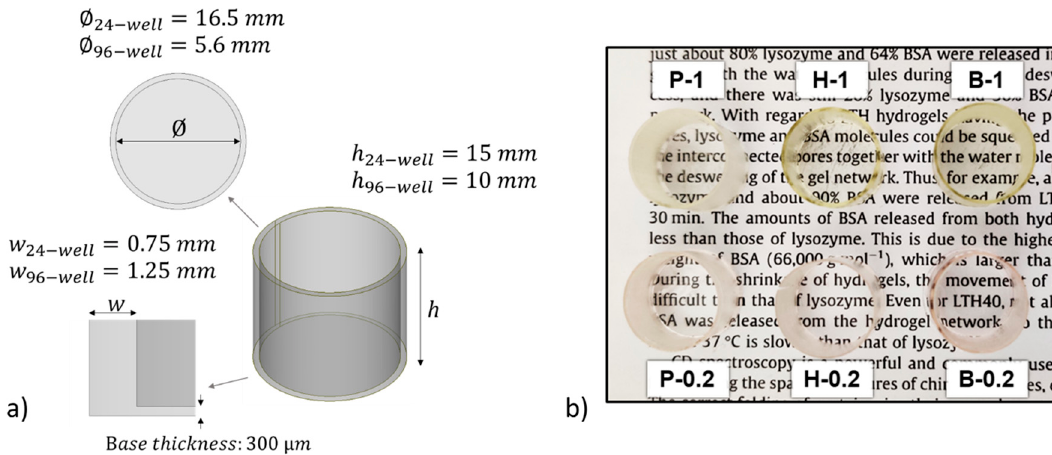
Figure 2. ( a ) Isometric view of the CAD designs showing the dimensions for 24- and